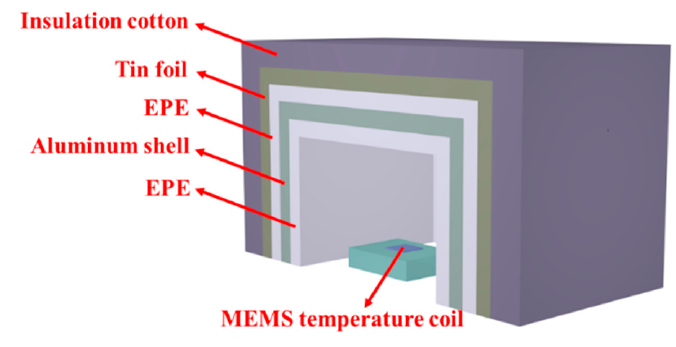
Figure 9. Schematic diagram of long-term noise floor test.